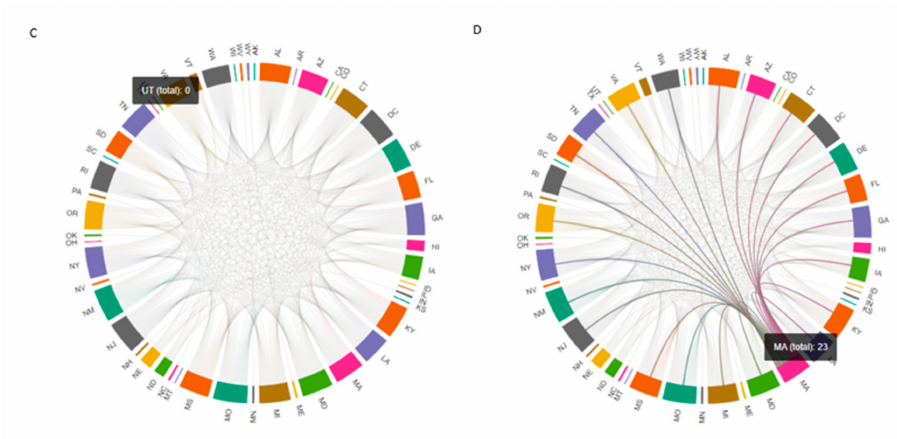
Figure 2. The COVID-19 correlation network for all US states ( A ), Arizona ( B ), Utah ( C ), and Massachusetts ( D ) (Please refer to https://github.com/RezaDavahli/Graph_neural_networks for live figure; accessed on 10 March 2021).